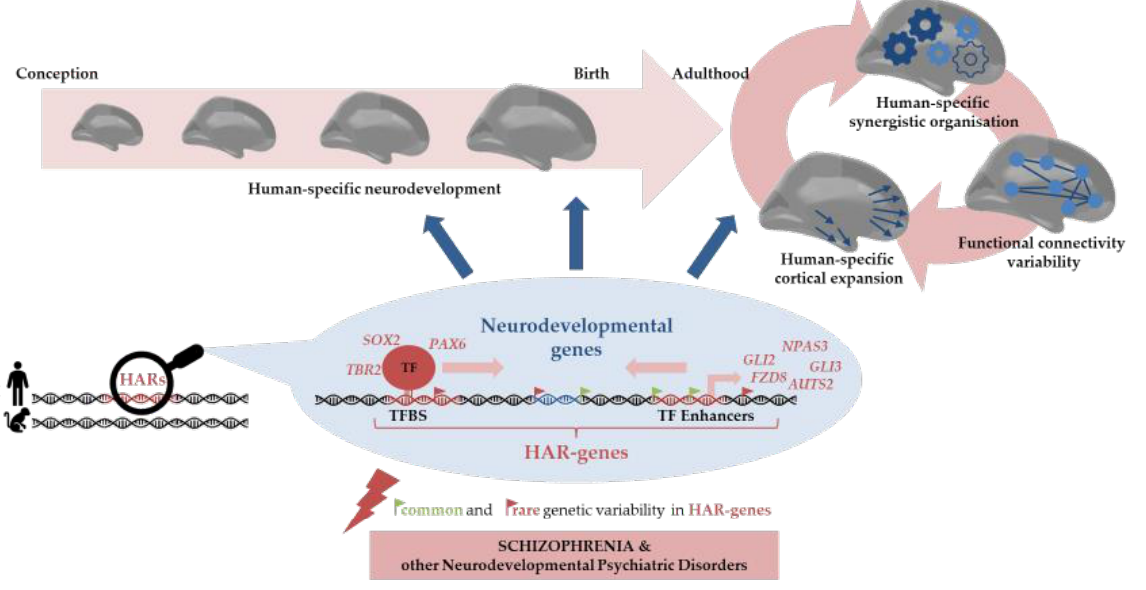
Figure 2. Graphical summary of Human Accelerated Regions’ (HARs) impact on neurodevelopment, brain configuration, and associated psychiatric disorders. Middle panel: HARs are evolutionarily conserved genomic regions across mammals’ evolution that accumulated human-specific (H) changes since the divergence from chimpanzees (C). Molecular studies evidence that HARs function as transcription factor binding sites (TFBS) or transcription factors (TF) of genes involved in neurodevelopmental pathways [52,58–60]. Top panel: The key roles of HARs in the neurodevelopmental gene regulatory machinery underlie the human-specific neurodevelopmental characteristics sustaining human-specific brain architecture, information processing, and variability in neural integration, brain traits, which in turn are associated with different psychiatric disorders [66–68]. Bottom panel: Common and rare genetic variability in HARs and HAR genes is related to changes in the neurodevelopmental trajectories, and therefore, sustains the inherent human variability in cognition, intelligence, behaviour, and sociability traits [66,69], but also the neural dysfunction observed in the neurodevelopmental disorder continuum. Additionally, the described effect of HAR genomic variability on the genetic determinants underlying schizophrenia and other neurodevelopmental psychiatric disorders [52,58,66,69,71,73] strengthens the paramount role of HARs in the neurodevelopmental